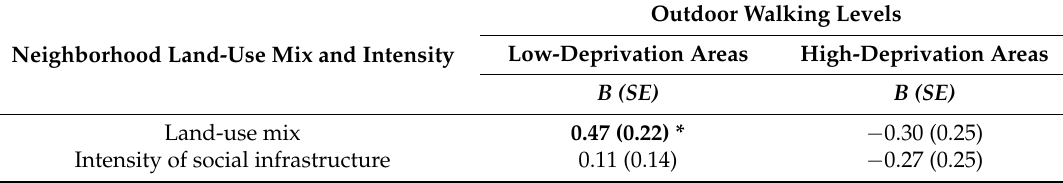
Table 7. Results of hierarchical analyses: relationships between neighborhood land-use mix and intensity, and outdoor walking levels in low- and high-deprivation